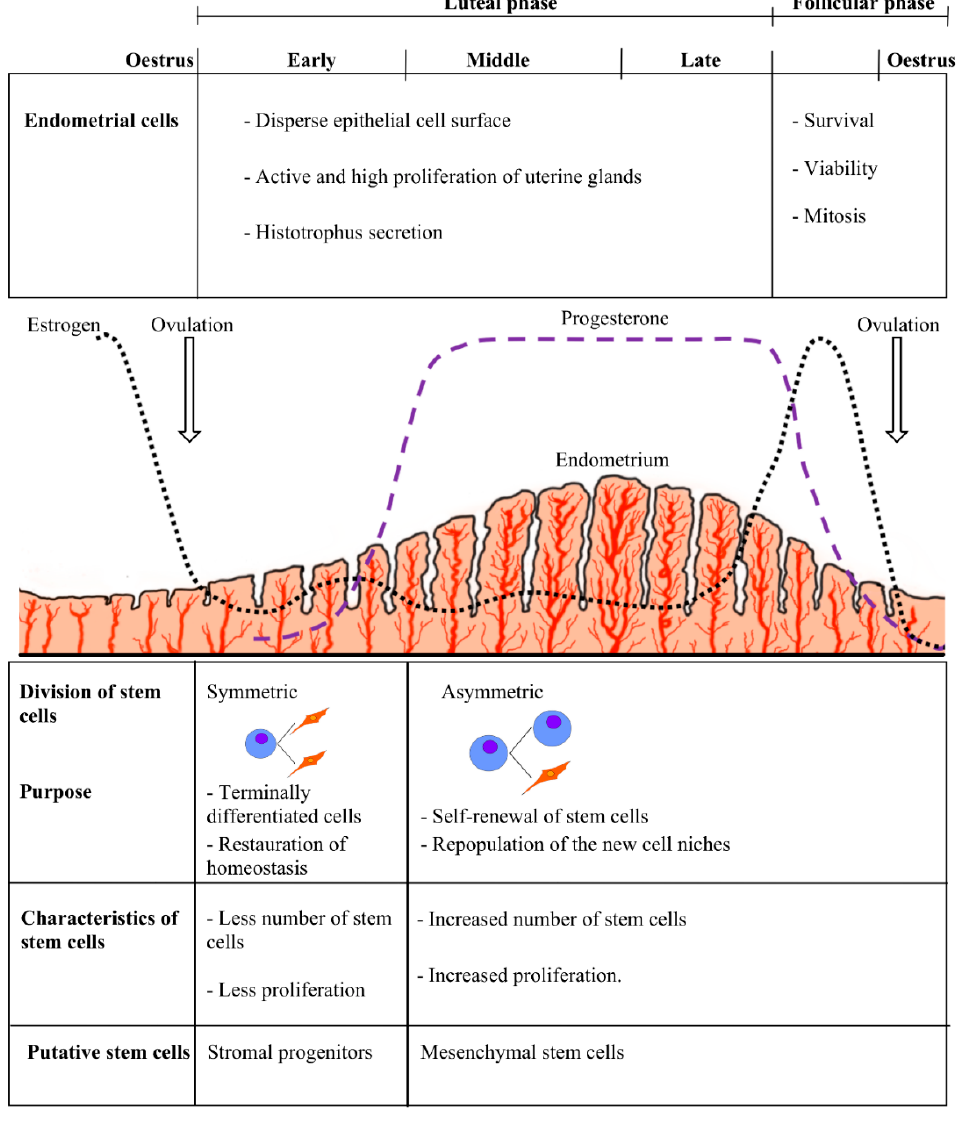
Figure 1. Stem cells and hormonal variation in the estrous cycle, indicating the relation between the type and characteristics of the stem cells with the appropriate stages of the estrous cycle in a hypothetical animal model.